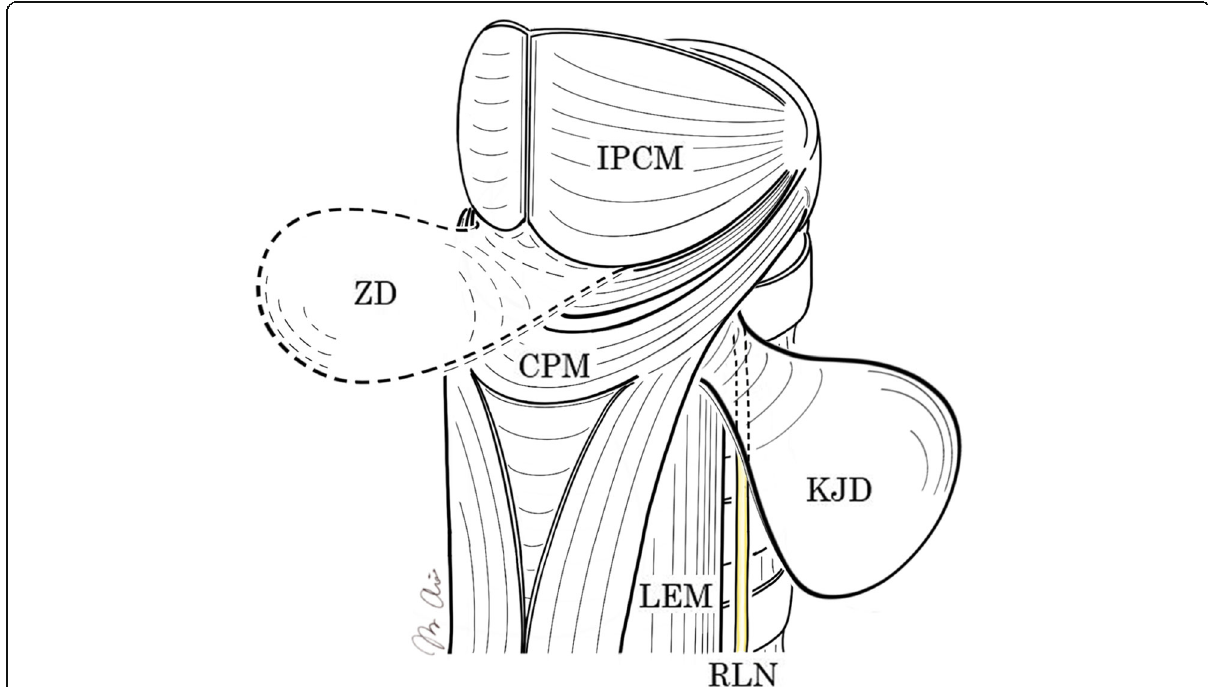
Fig. 5 Anatomical structure of the hypopharynx and cervical esophagus. ZD, Zenker ’ s diverticulum; KJD, Killian-Jamieson diverticulum; RLN, recurrent laryngeal nerve; IPCM, inferior pharyngeal constrictor muscle; CPM, cricopharyngeus muscle; LEM, longitudinal esophageal